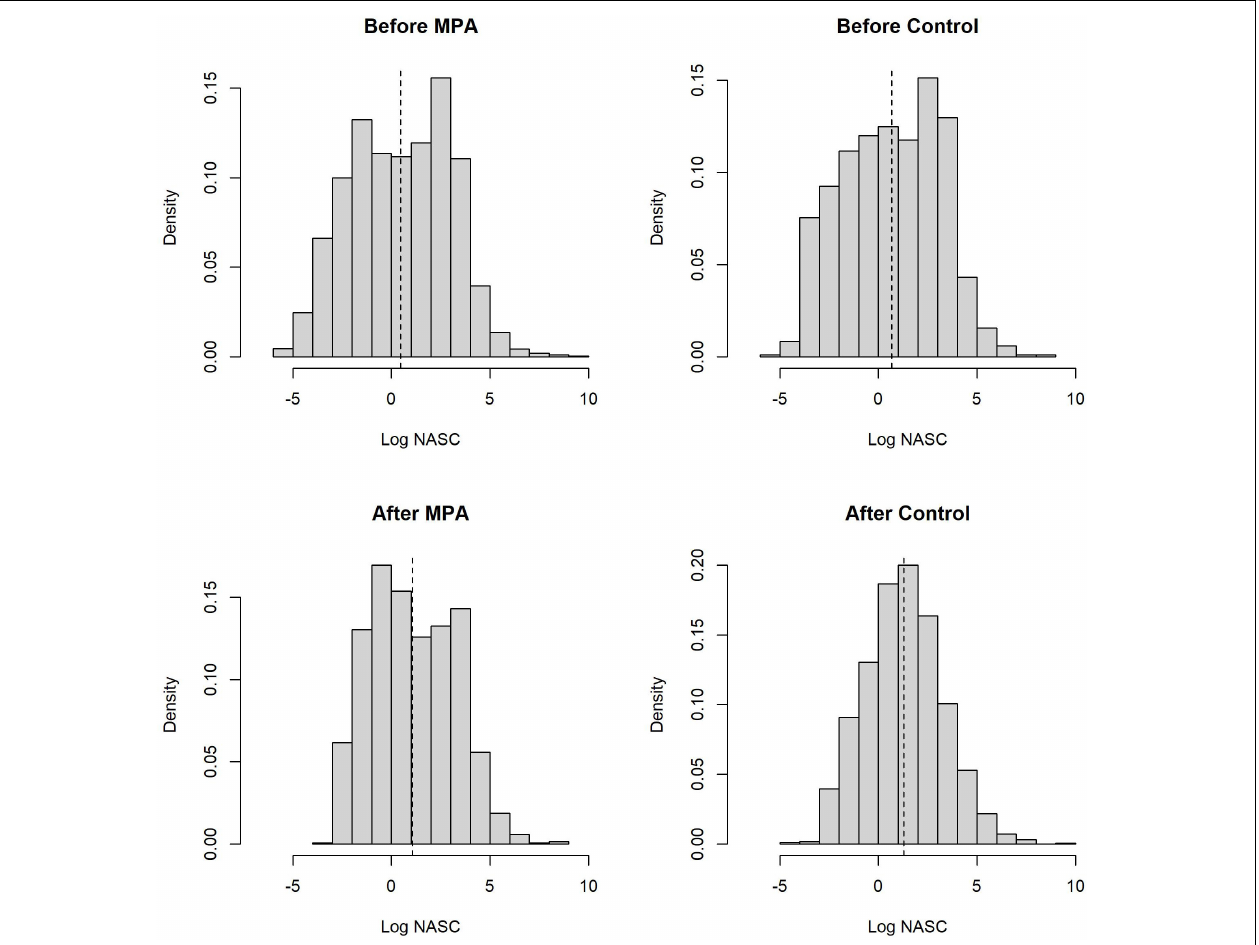
FIGURE 2 | Distributions of the natural logarithm of all non-zero biomass observations from our sonar analysis, broken down by Area and Period. Each observation represents the total biomass volume (NASC) per 100 m grid cell. Vertical dashed lines are the mean of the